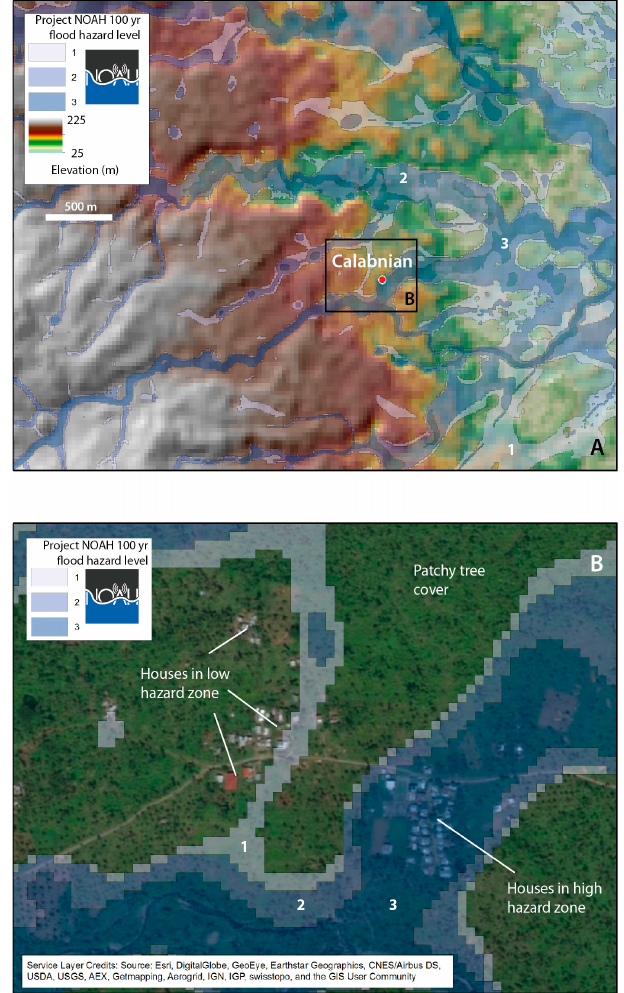
Figure 8. ( A ) Calabnian is located close to the edge of a low terrace between rivers located to the north and south. Elevation model derived from NASA SRTM [60]. ( B ) Satellite image of Calabnian showing housing clusters in high and low hazard zones. Base map provided by ESRI. The flood hazard levels in both images ( A , B ) are taken from the Project NOAH 100-year return event.